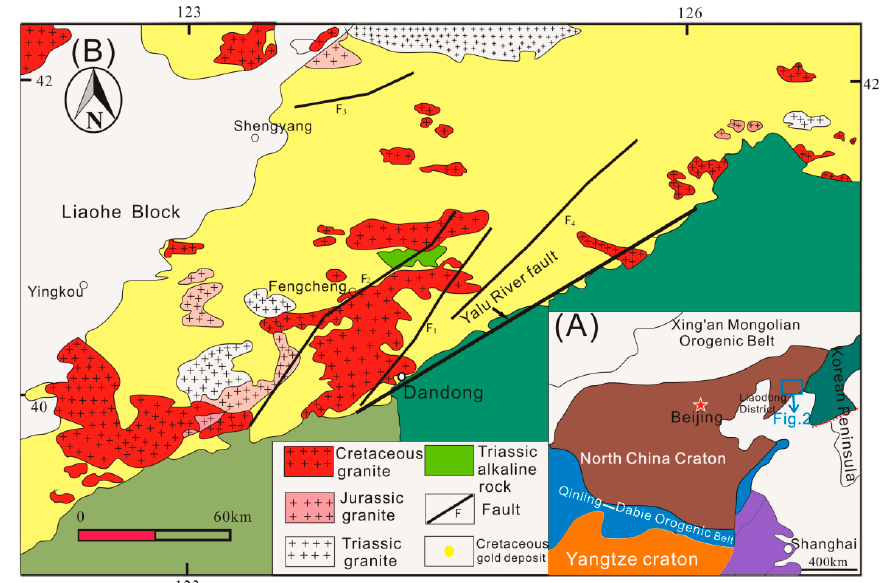
Figure 1. ( A ) Simplified geological map of eastern China, showing major tectonic units; rectangle outlines the study area; ( B ) geological map showing distribution of Mesozoic intrusions in the Liaodong Peninsula [12].